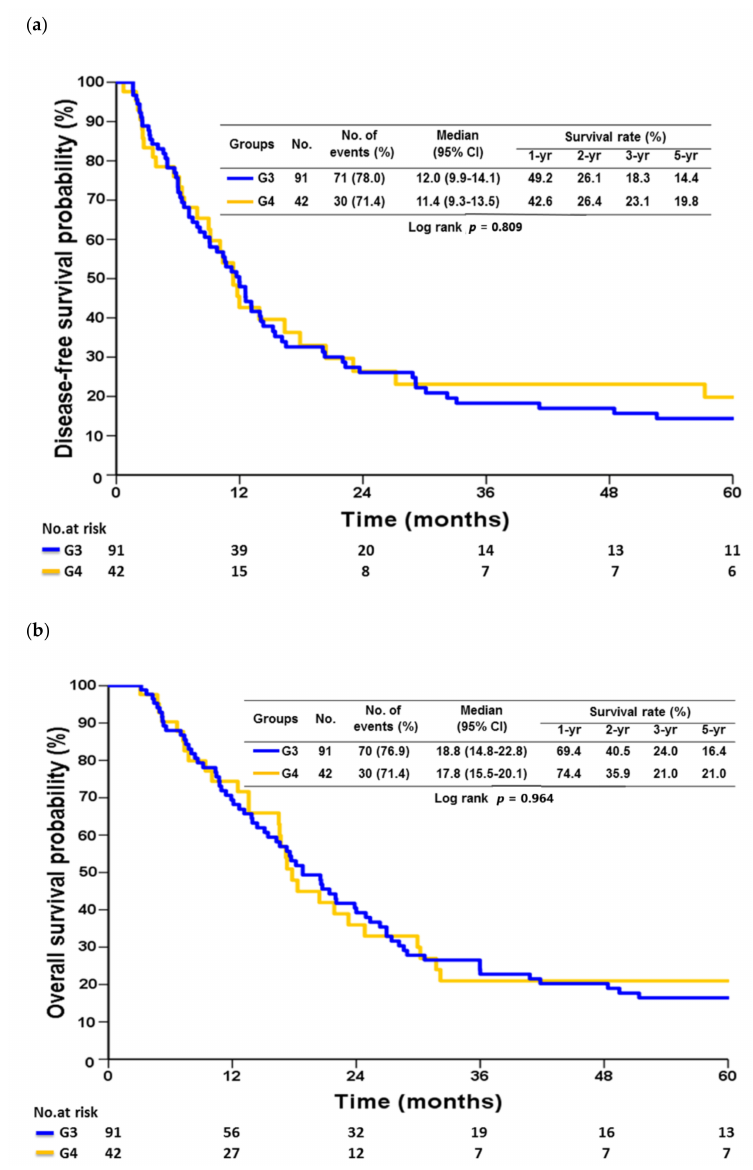
Figure 2. Disease-free survival ( a ) and overall survival ( b ) between G3 and G4